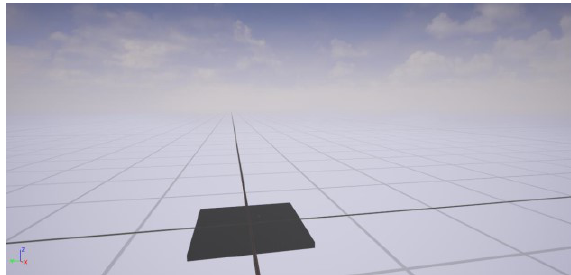
Figure 6. The 3D virtual environment